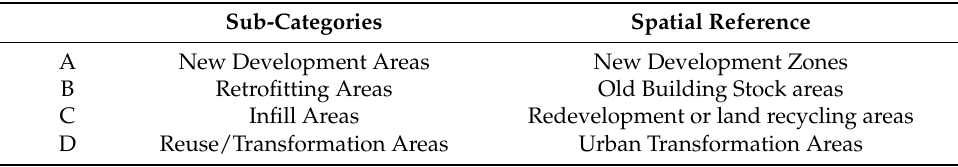
Table 2. Category 2: Urban macroform.